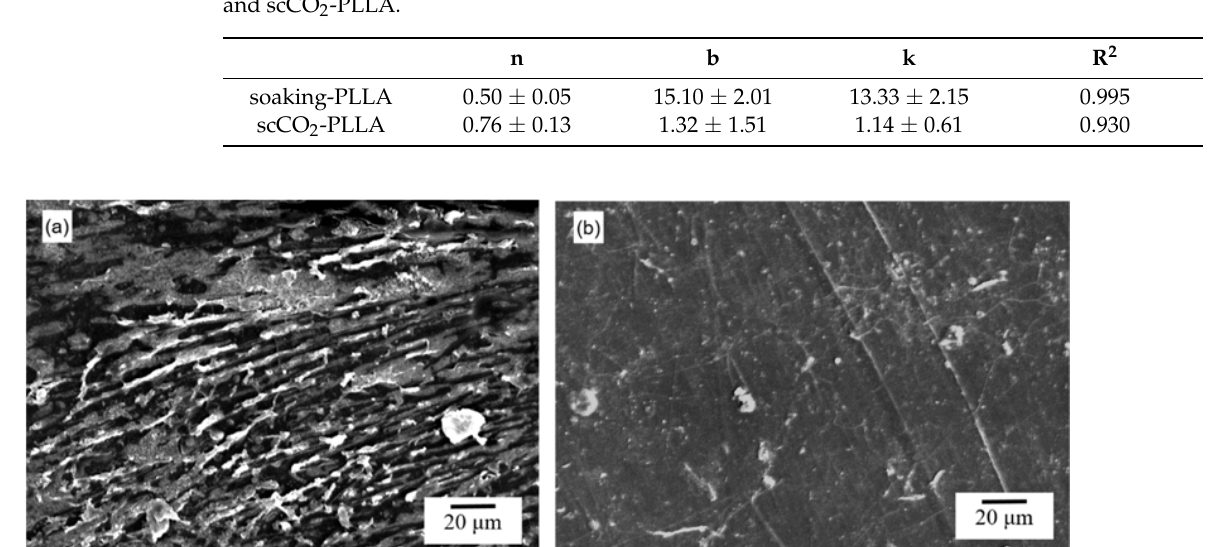
Figure 11. SEM images of soaking-PLLA immersed in 1 M PBS at 37 °C ( a ) for 30 min, and ( b ) for 1.5 h.